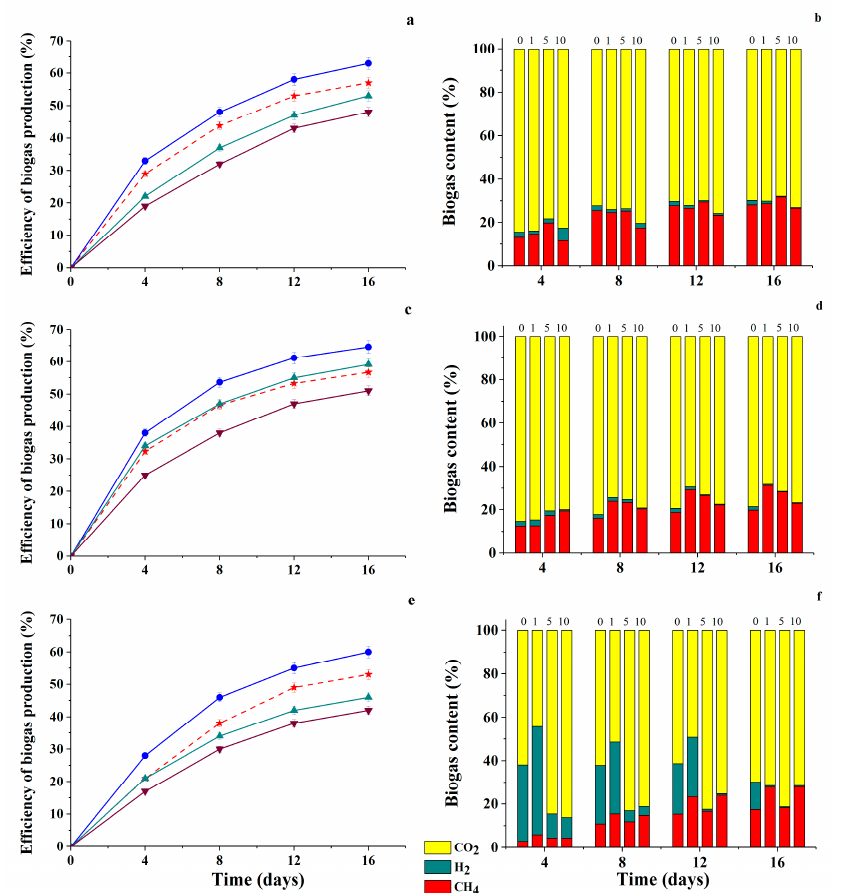
Figure 6. Efficiency of biogas production and biogas content during anaerobic cultivation of natural anaerobic consortia—the 1st ( a , b ), 2nd ( c , d ), 3rd ( e , f )—in media containing 1 g/L glucose and different concentrations of FA-HQ (g/L): 1— , 5— and 10— , ( —control sample without HC in the medium). The theoretical maximal conversion of substrate to biogas was assumed as 100% efficiency of biogas production.